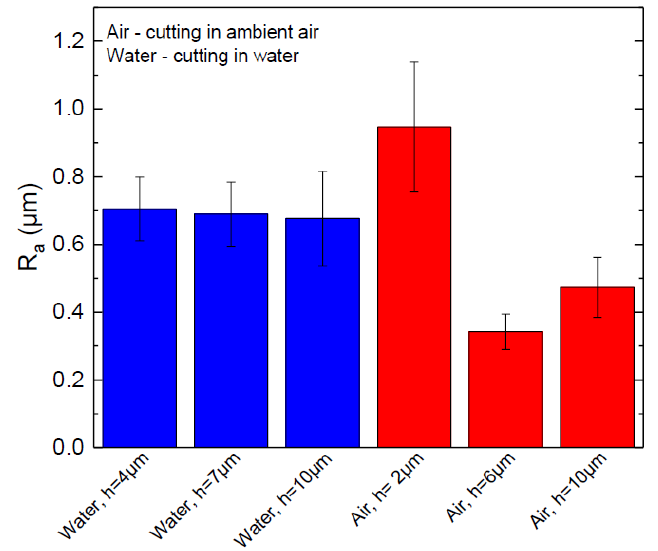
Figure 15. Cut wall roughness ( R a ) versus hatch in ambient air and water. Error bars indicate standard deviation.